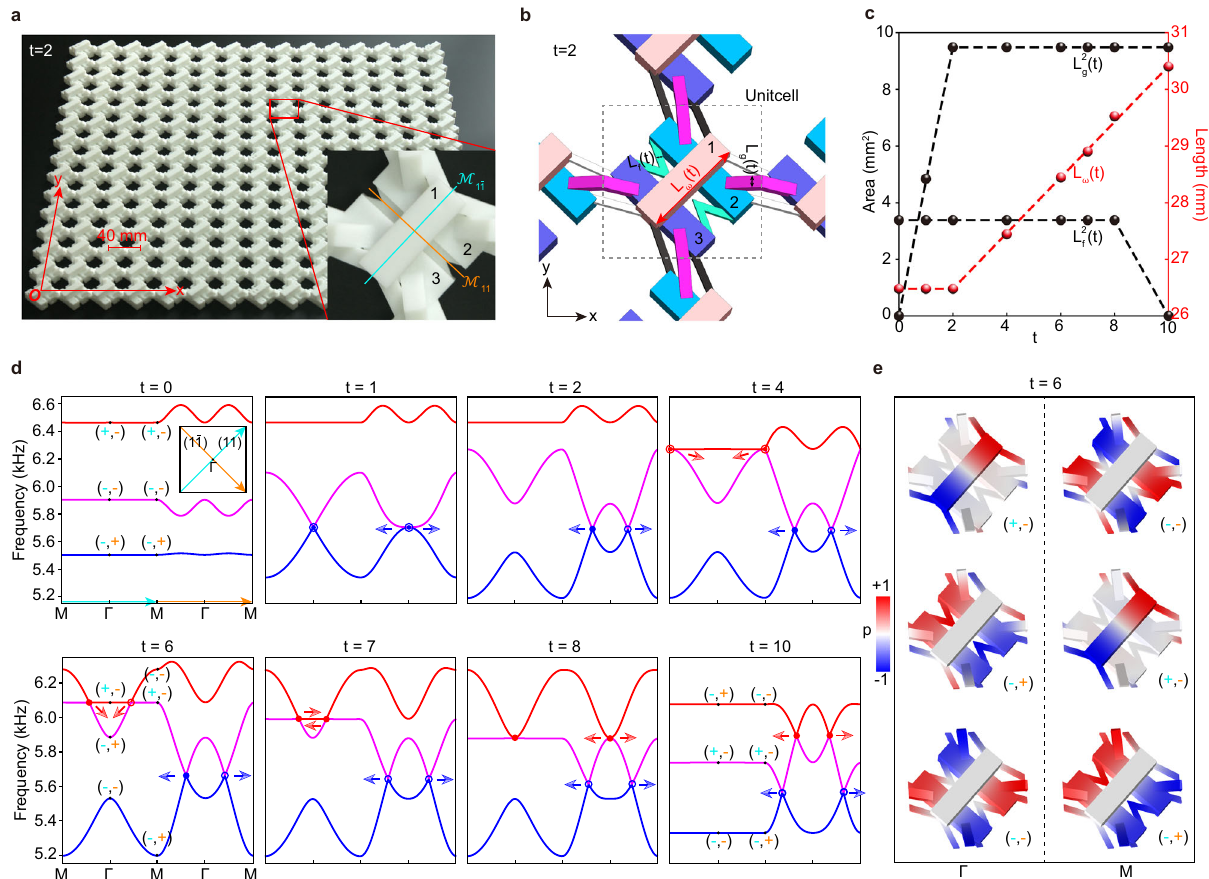
Fig. 2 | Acoustic realization of elementary braiding model. a A photo of our square-lattice acoustic metamaterial (with t =2). The lattice constant a =40 mm. Inset: an enlarged view of the unit cell with two mirrors labelled. b Unit-cell structure of our acoustic metamaterial, highlighted with three variable geometry parameters. c Time evolution of the geometric parameters. The discrete spheres correspond to our acoustic metamaterials at eight moments, and the dashed lines are fi tted piecewise linear functions. d Band structures at different moments